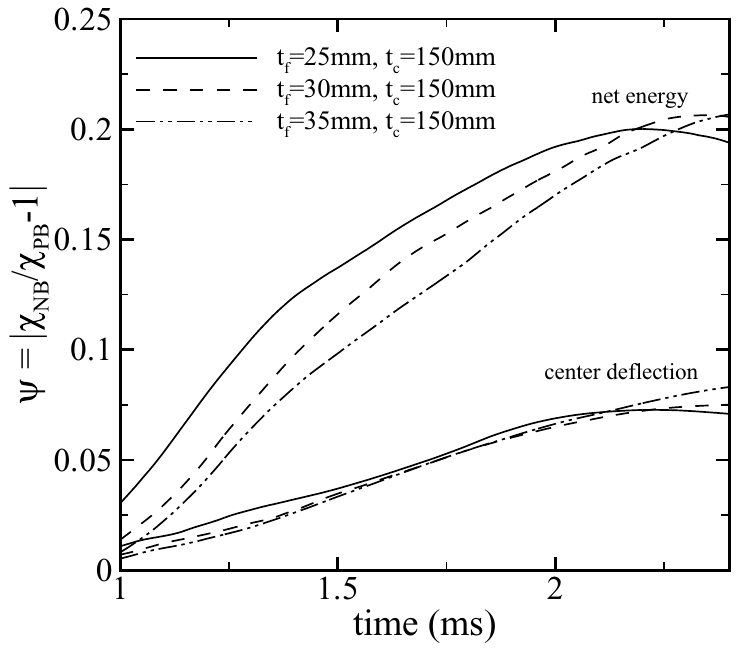
Fig. 18. Parametric studies on the influence of face-to-core thickness ratios on the mid-span deflection and net energy absorption ratios between the perfect- and no-bonding sandwich plates with clamped ends.